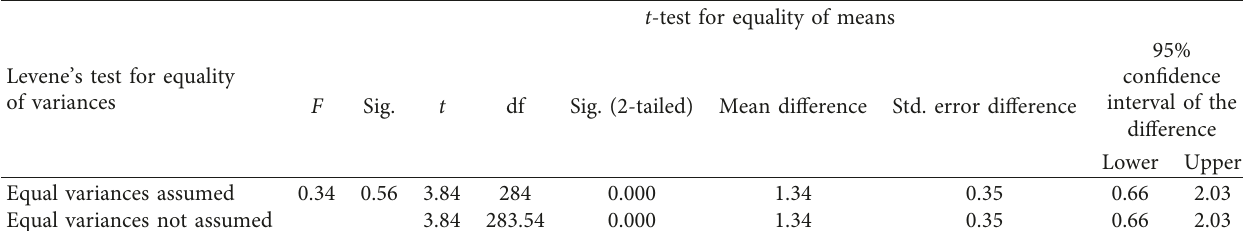
Table 5: Independent samples